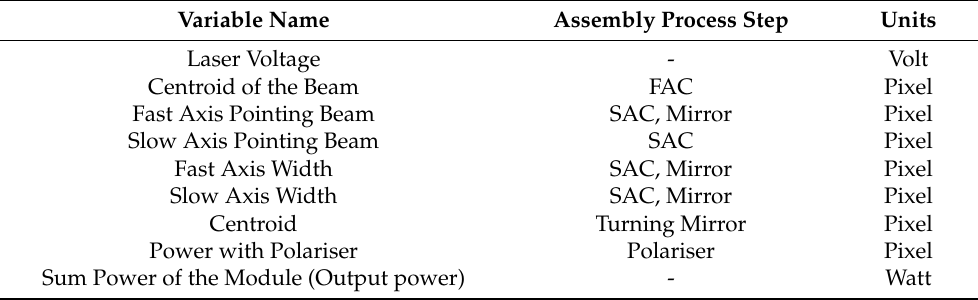
Table 3. Important input variables of the d-serie laser module.